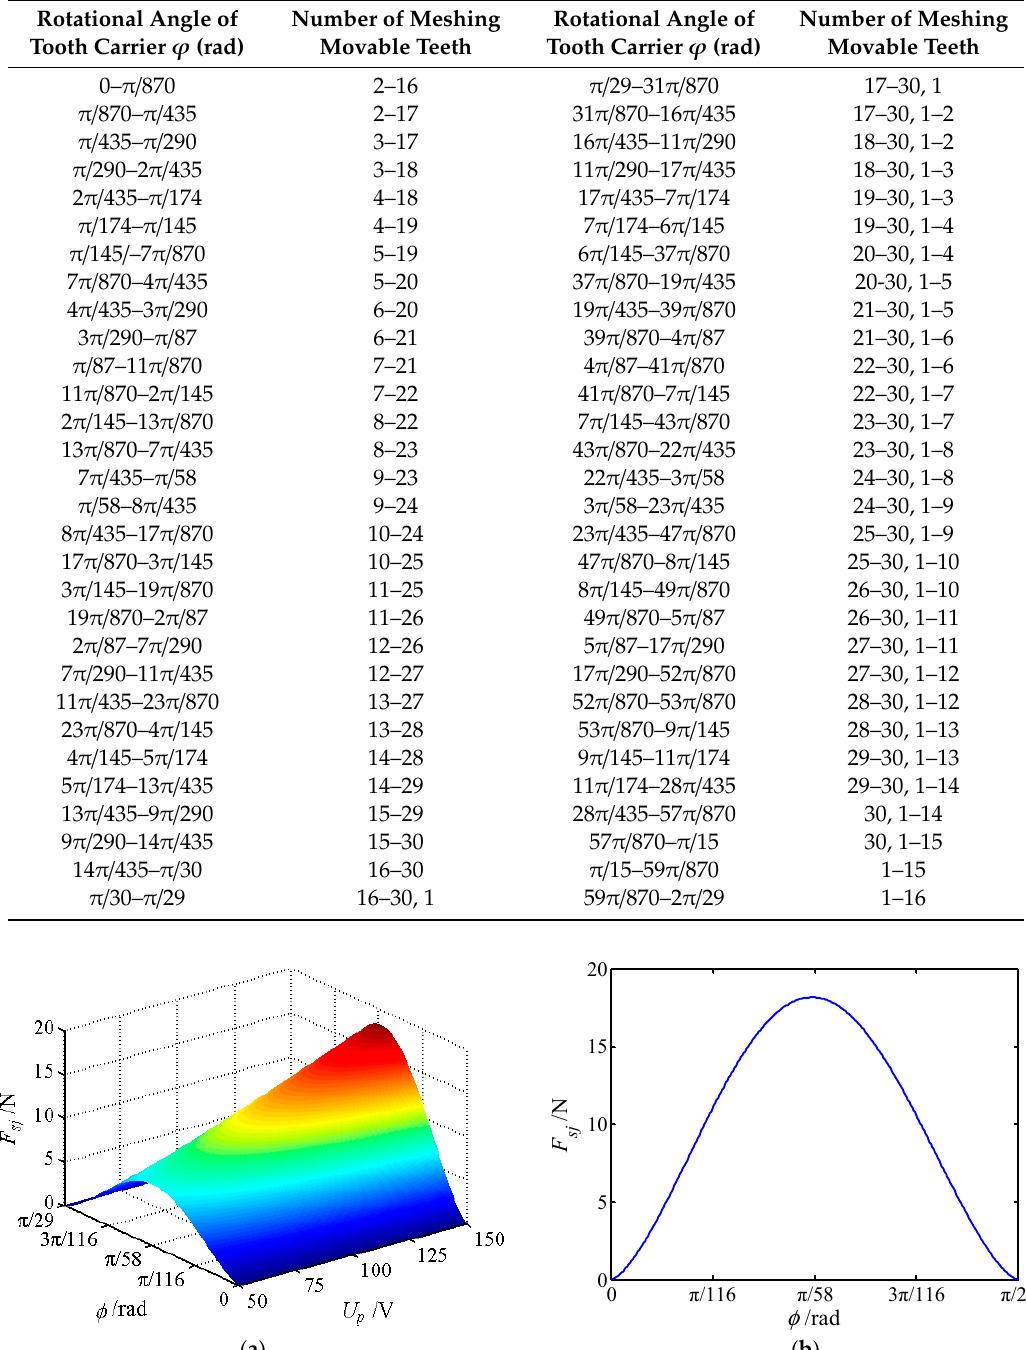
Table 1. Number of meshing movable teeth of di ff erent positions in a period.